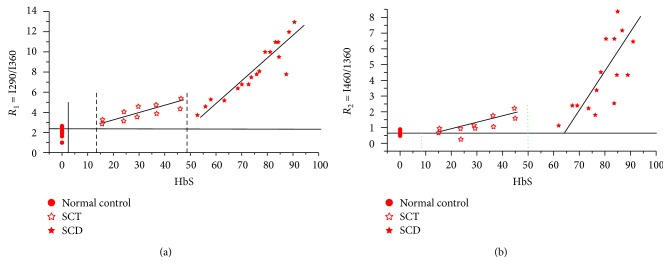
(a) The ratio of R1 for SCT and SCD. (b) The ratio of R2 for SCT and SCD.